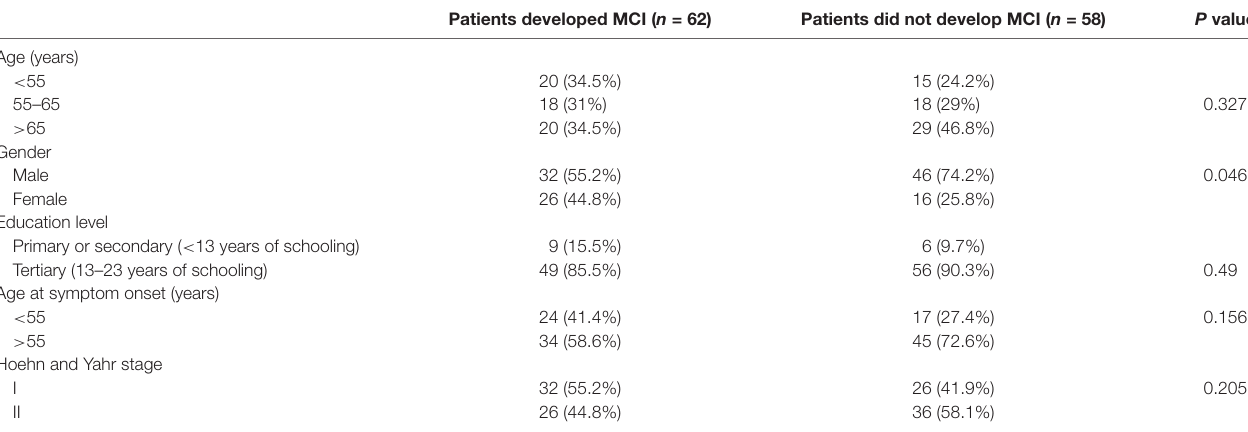
TABLE 1 | Basic characteristics of PD-RBD patients with different cognitive